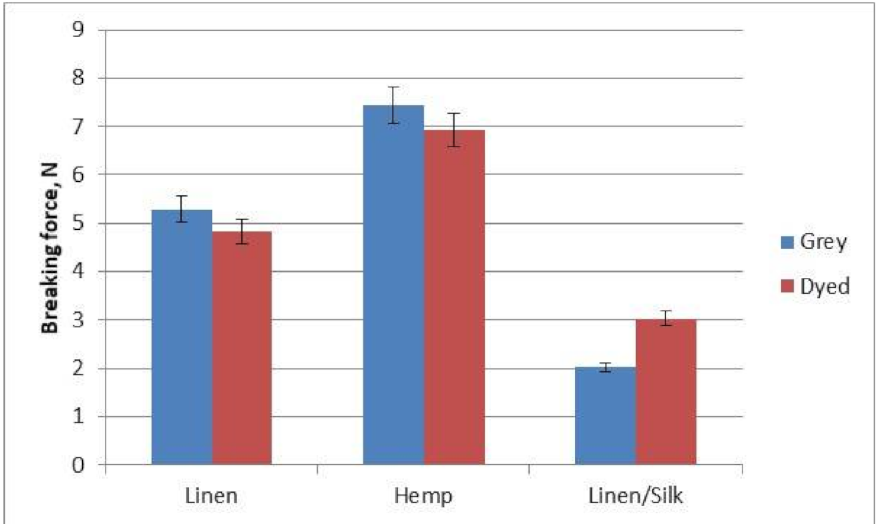
Figure 7. Diagram of the yarns’ breaking